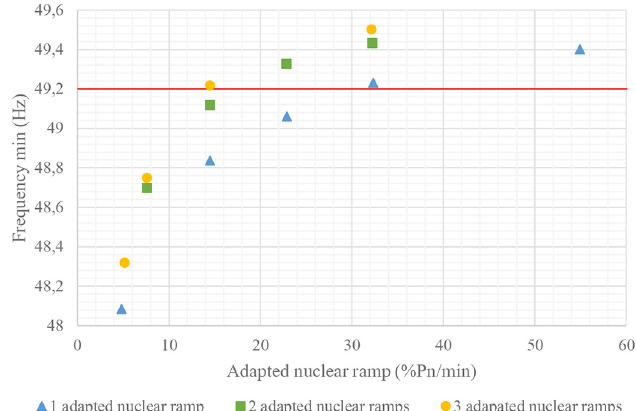
Fig. 12. Dip frequency as a function of the adapted nuclear ramp for 150 MW solar RE power drop.